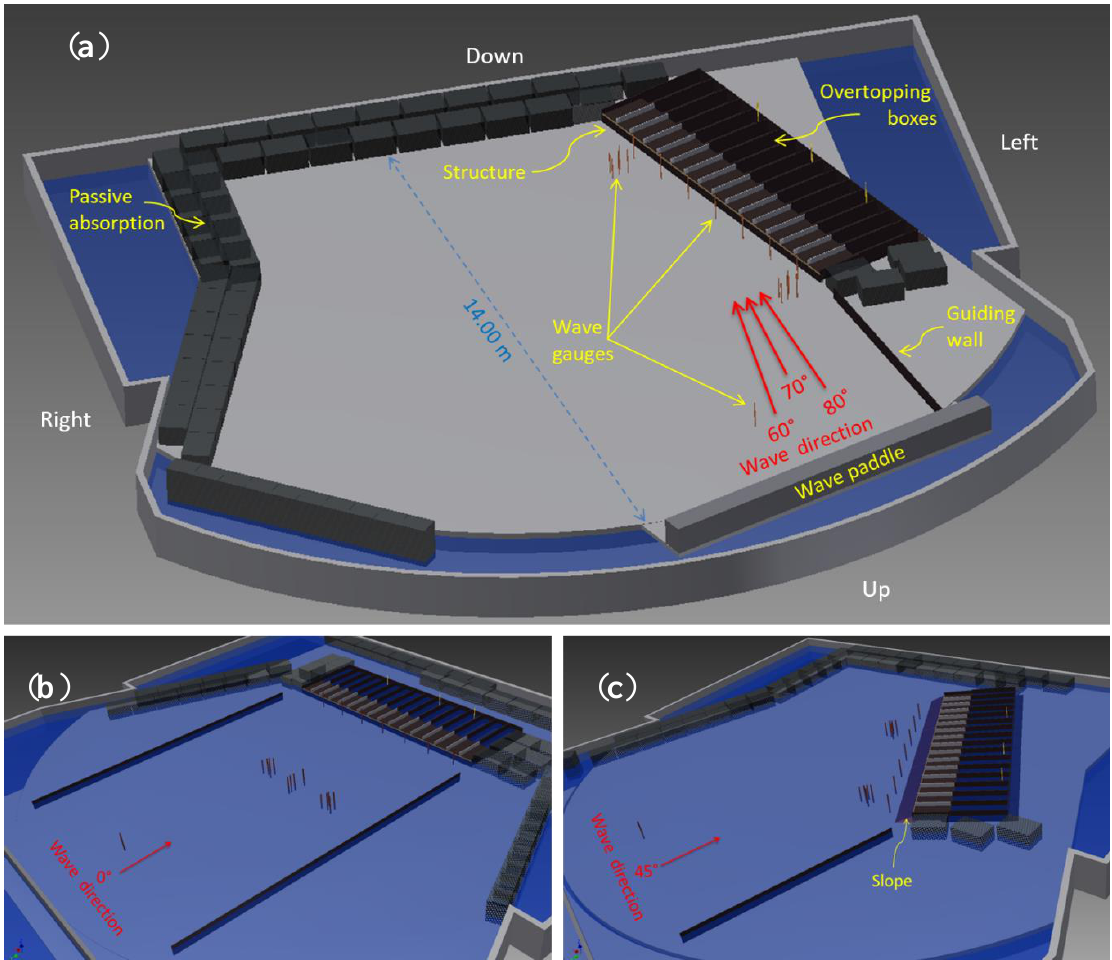
Figure 3. The position of the structure in the wave basin during experiments: ( a ) wave directions 60°, 70° and 80°; ( b ) perpendicular wave attack; ( c ) wave direction 45°.